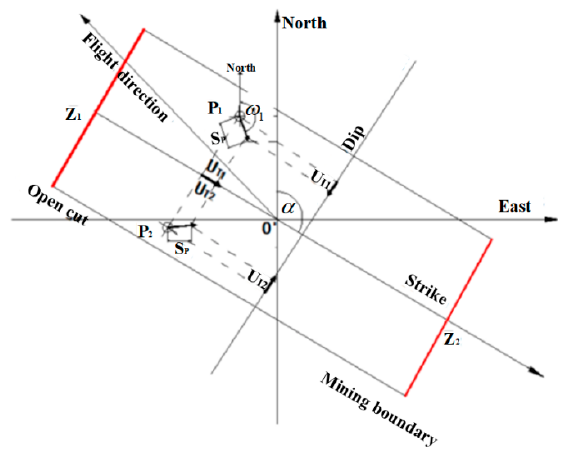
Figure 4. The horizontal movement of the surface during mining.